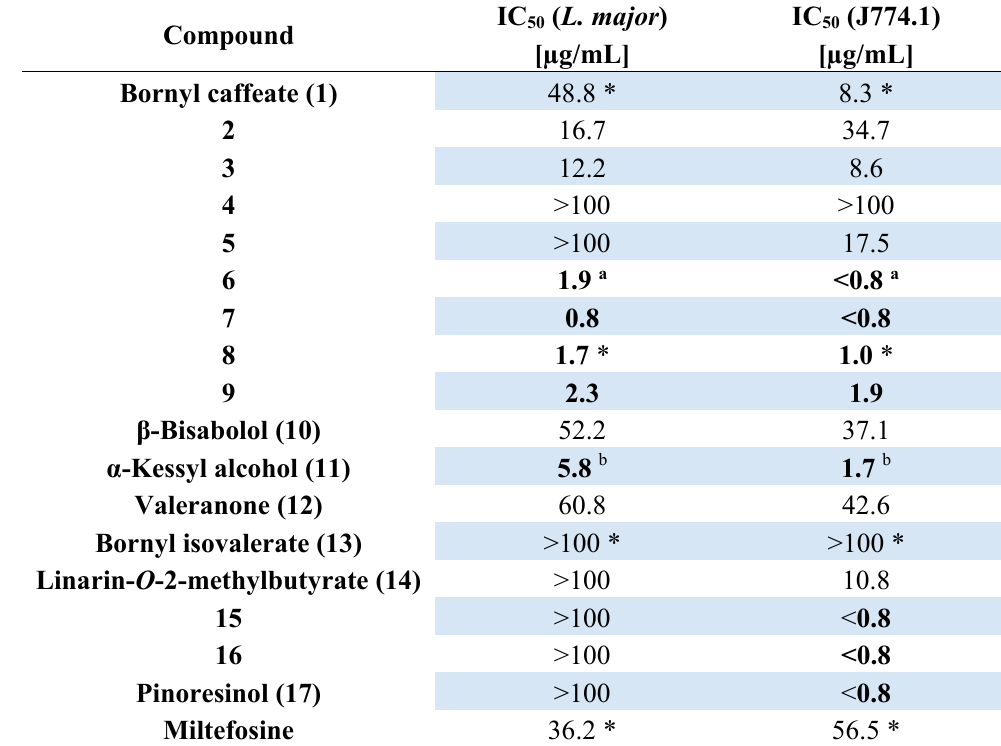
Table 2. Antileishmanial activity and cytotoxicity of fractions containing isolated